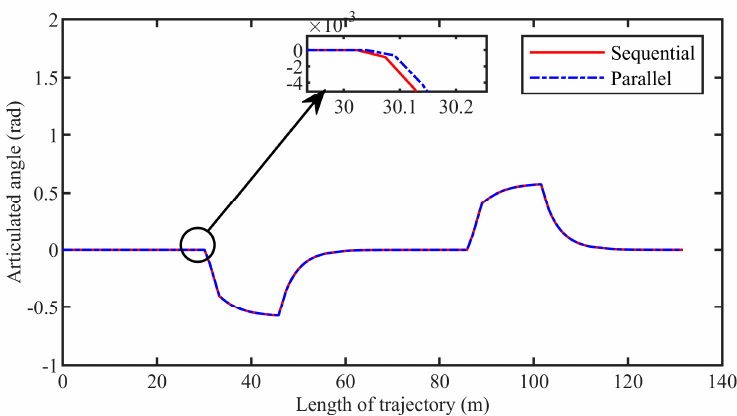
Figure 13. The articulated angle of the comparison between calculation processes.